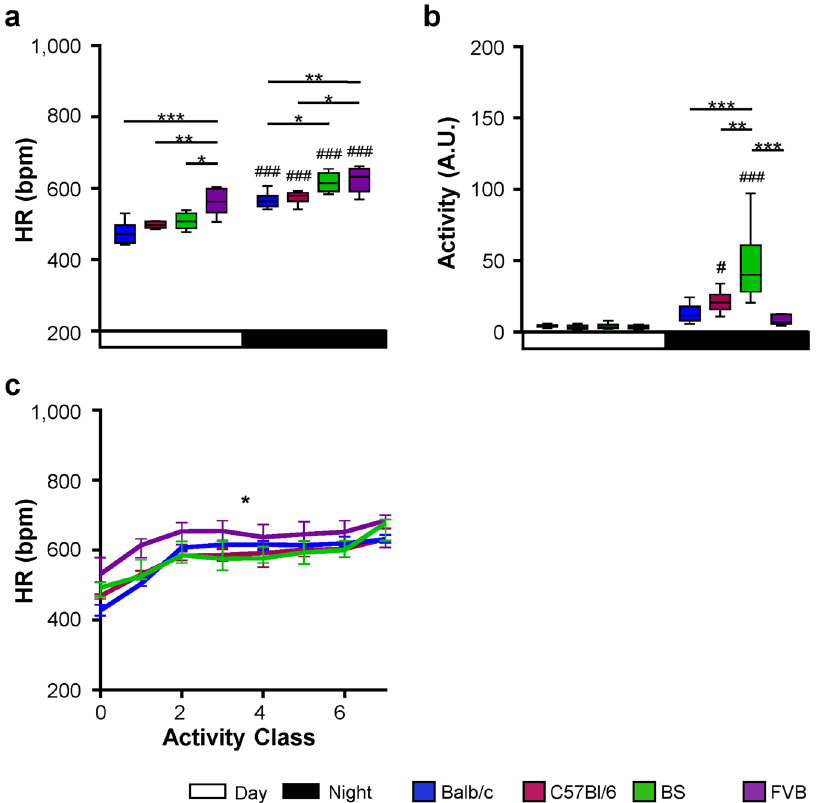
Figure 3. Heart rate and physical activity under baseline conditions. ( a ) HR and ( b ) physical activity during day- and night-time calculated from 96 hours ECG recordings as shown in Fig. 2. Activity was derived as a parameter (activity units; A.U.) from the telemetric transponders and corresponds to the physical activity of the animals in the cage. ( c ) HR normalized to activity. For this, the absolute activity units (A.U.) were binned in the following classes: 0 = 0 A.U., 1 = 0–5 A.U., 2 = 5–10 A.U., 3 = 10–15 A.U., 4 = 15–20 A.U., 5 =